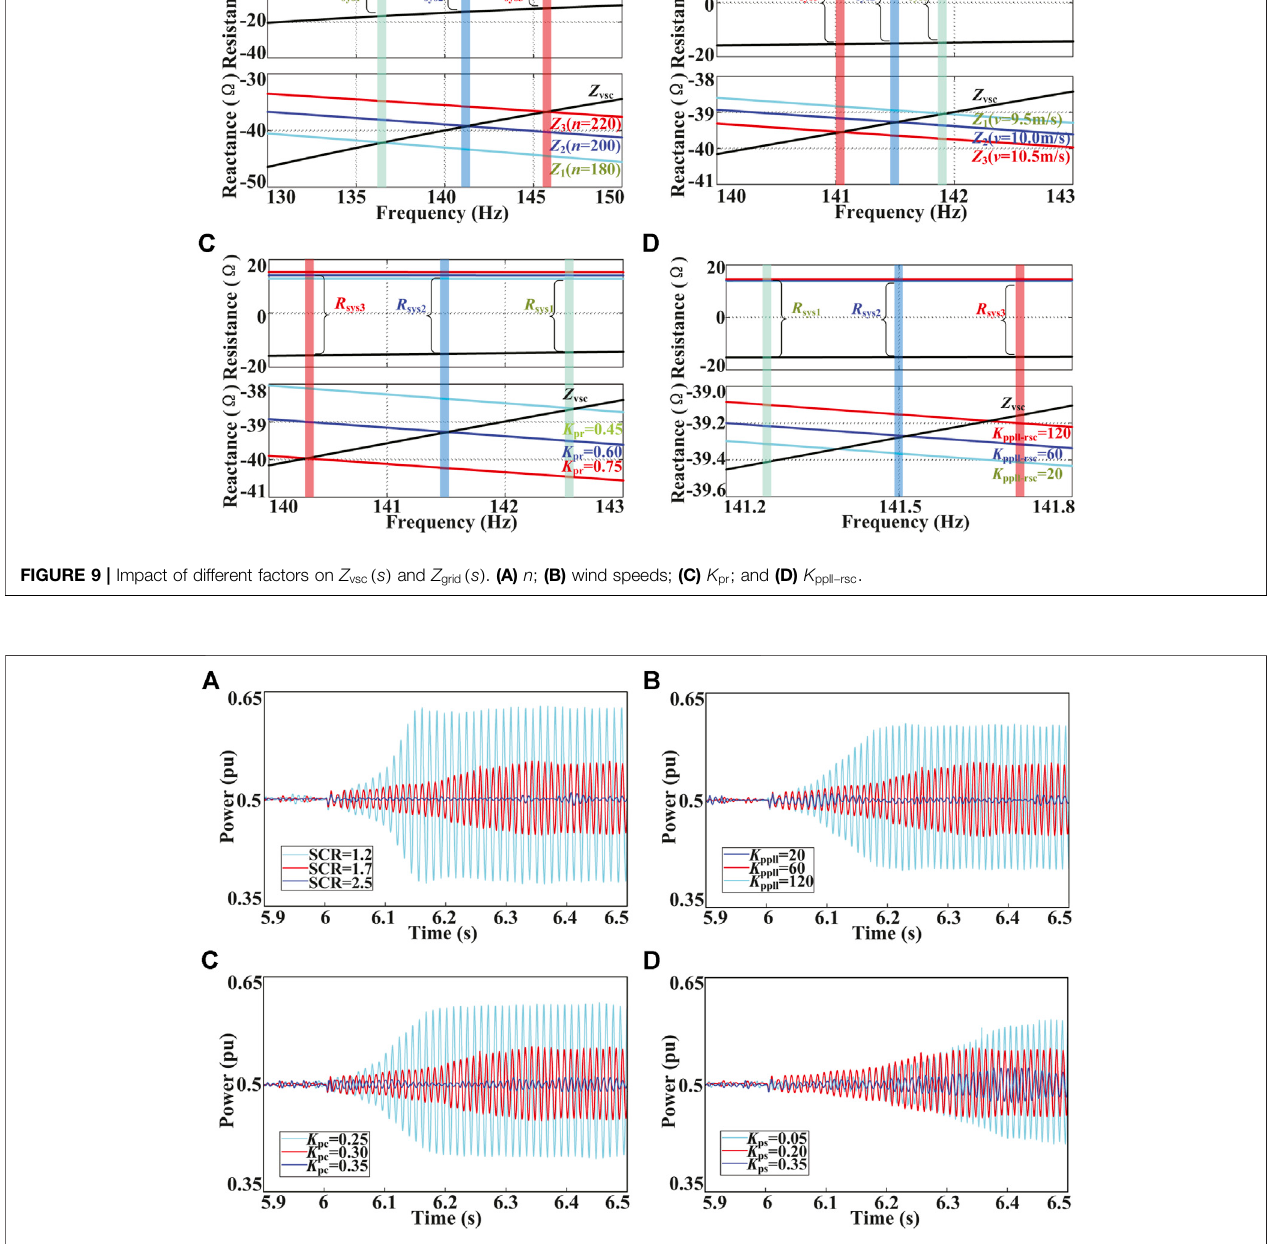
FIGURE 10 | Output power varies with (A) SCR, (B) K ppll , (C) K pc , and (D) K ps